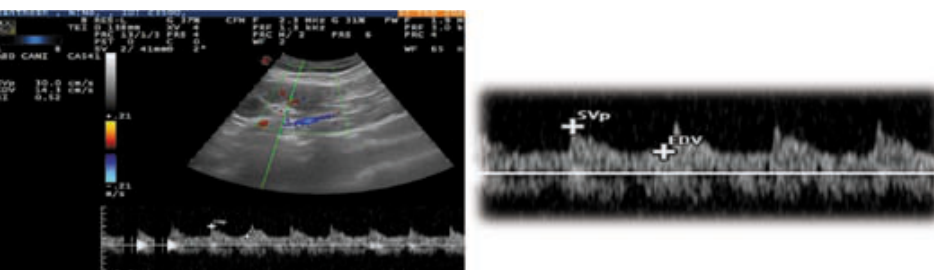
Fig. 1. Ultrasound image showing measurement of kidney size by measuring kidney length (between cursors) and aorta diameter (right) to obtain a ratio.